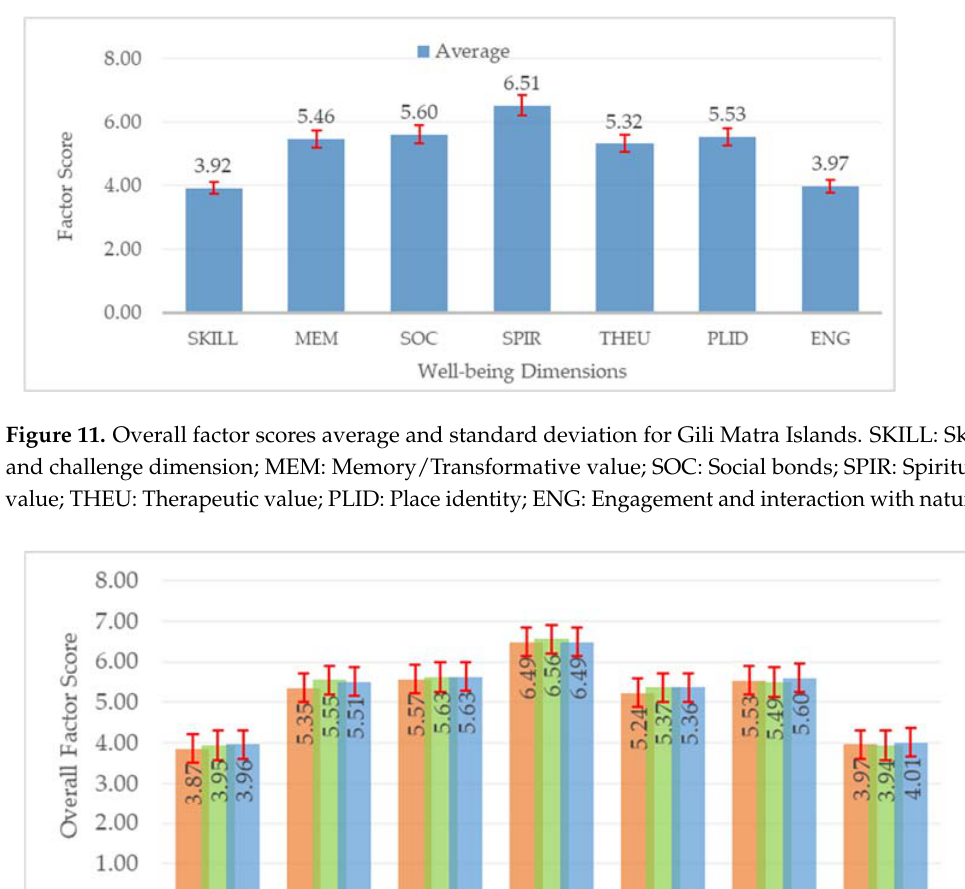
Figure 10. Structure of Model E1 using CFA analysis.